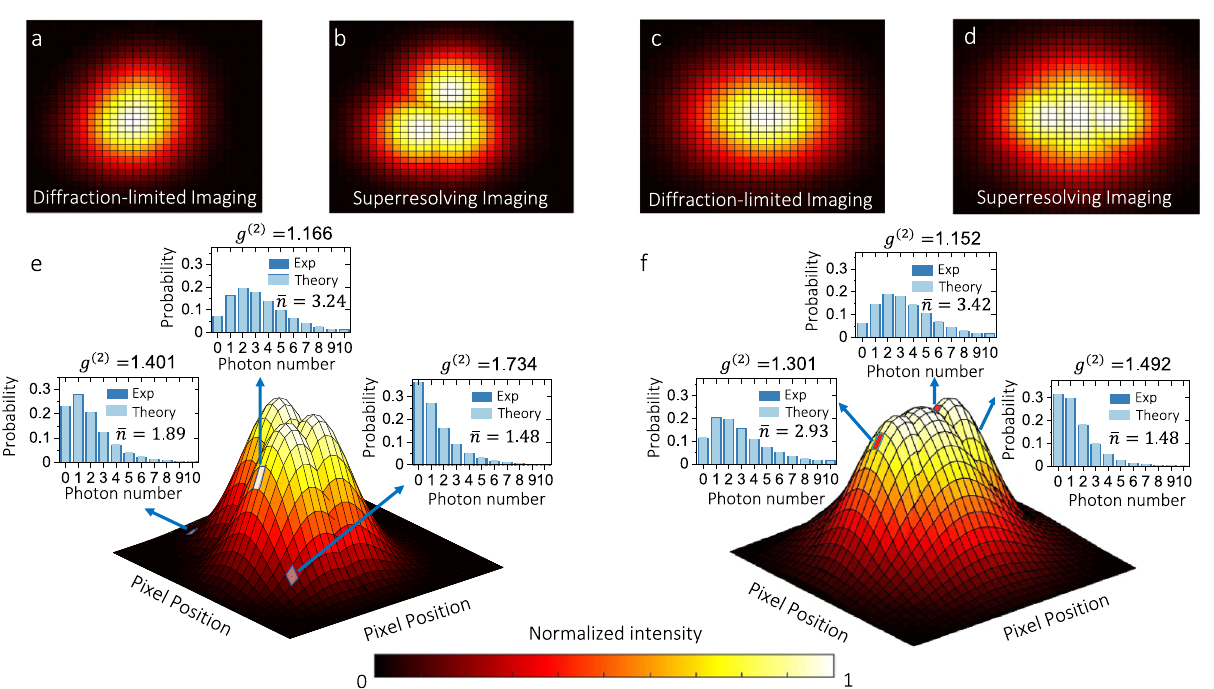
Fig. 4 Experimental superresolving imaging. The plot in a shows the combined intensity pro fi le of the three partially distinguishable sources. As stipulated by the Abbe-Rayleigh resolution criterion, the transverse separations among the sources forbid their identi fi cation. As shown in b , our smart quantum camera enables superresolving imaging of the remote sources. In c and d , we show another experimental realization of our protocol for a different distribution of light sources. In this case, two small sources are located inside the point-spread function of a third light source. The fi gures in e and f correspond to the inferred spatial distributions based on the experimental pixel-by-pixel imaging used to produce b and d . The insets in e and f show photon-number probability distributions for three pixels, the theory bars were obtained through Eqs. (2) and (3). These results demonstrate the potential of our technique to outperform conventional diffraction-limited